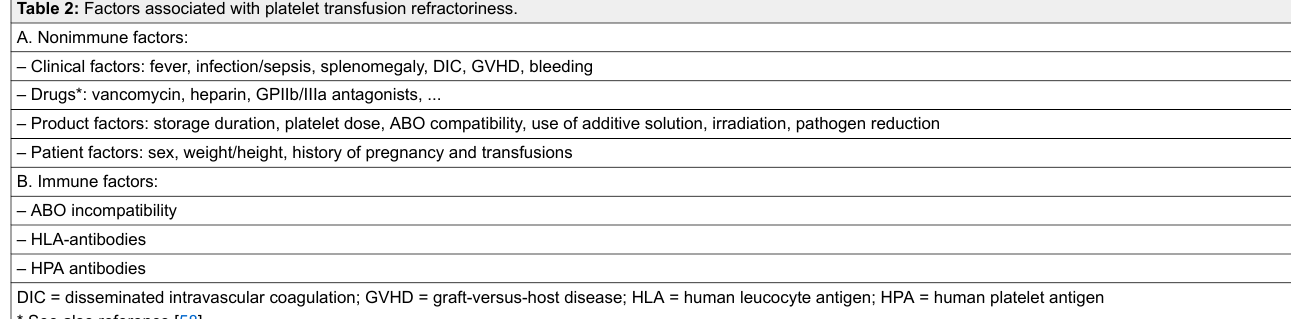
Table 2: Factors associated with platelet transfusion